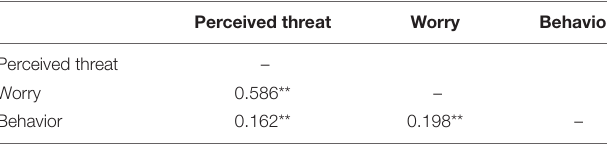
TABLE 5 | Correlations among Perceived threat, Worry, and Behavior.